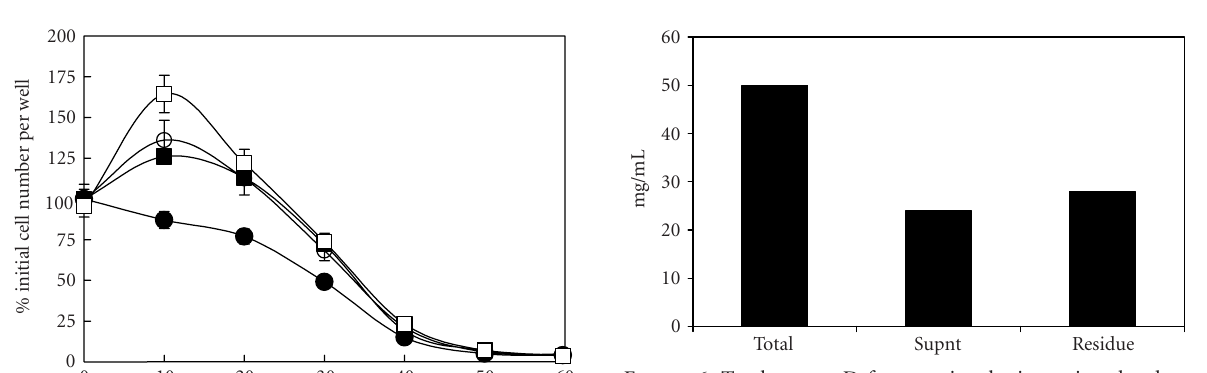
Figure 6. Total extract D from an incubation using the short protocol. The extract was dialysed in 0 . 15 N NaCl, and the protein recovery measured in the supernatant (supnt) and in the material that precipitated out during the dialysis (residue). These both retained decorin-like activity, as shown in Figure